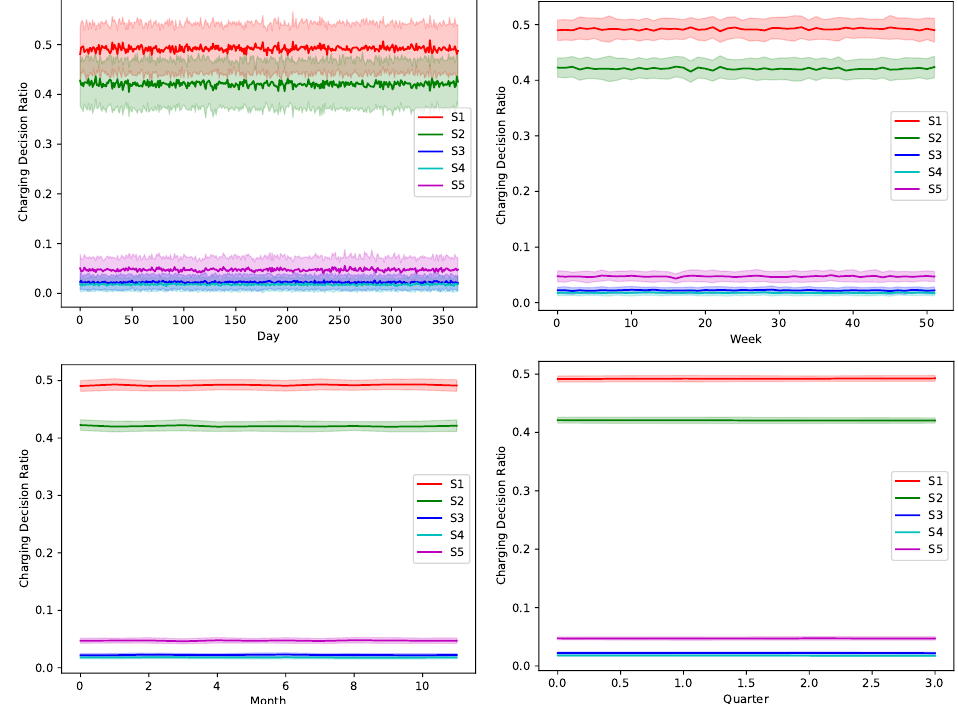
Figure 8. The temporal variation of the adopted charging decision by the greedy algorithm with a global certainty level U 10 .